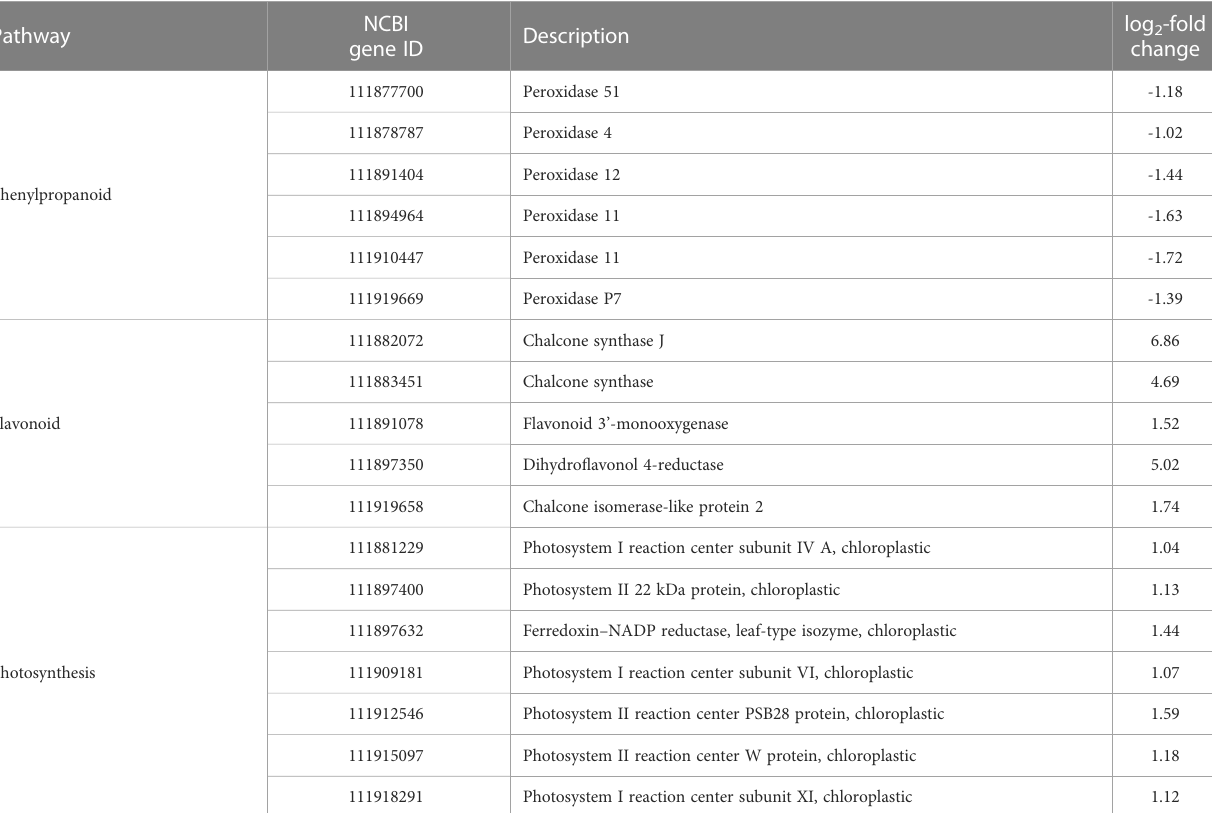
TABLE 3 Overview of three KEGG pathways and the mapped differently expressed genes (DEG) in chitin-treated lettuce plants (PS+CH) in comparison to untreated control plants (PS).